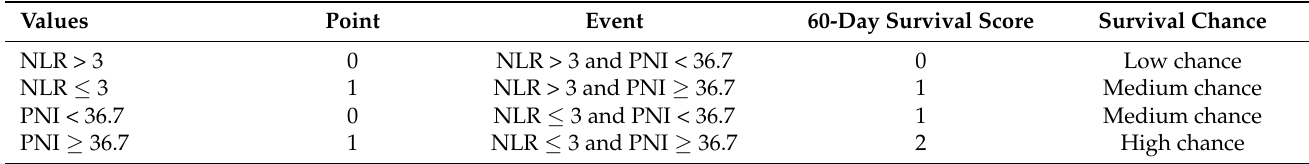
Table 3. 60-day survival score using cut-off values for NLR and PNI.